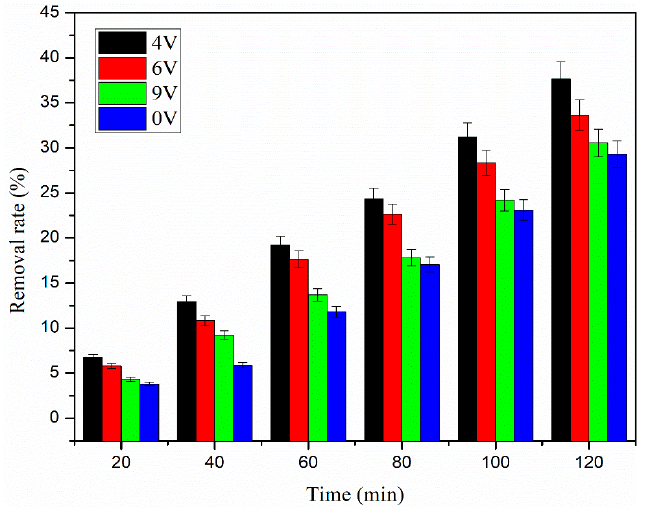
Figure 5. Influence of electrode potential on ciprofloxacin removal.